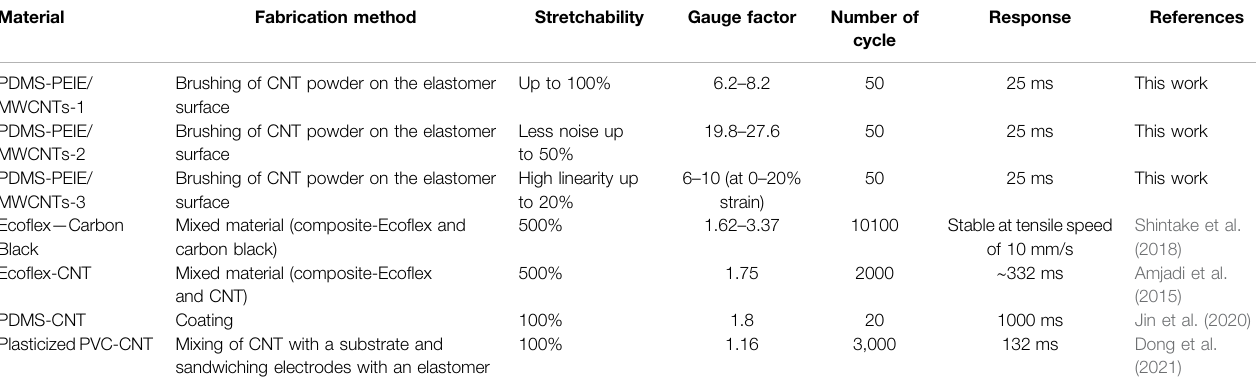
TABLE 1 | Comparison among the strain sensors fabricated using CNT and silicone elastomer as the stretchable electrodes.